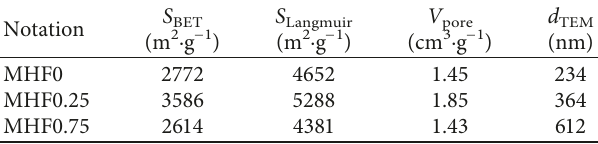
2 BDC. Table 1: Textural properties of MIL-101 samples.